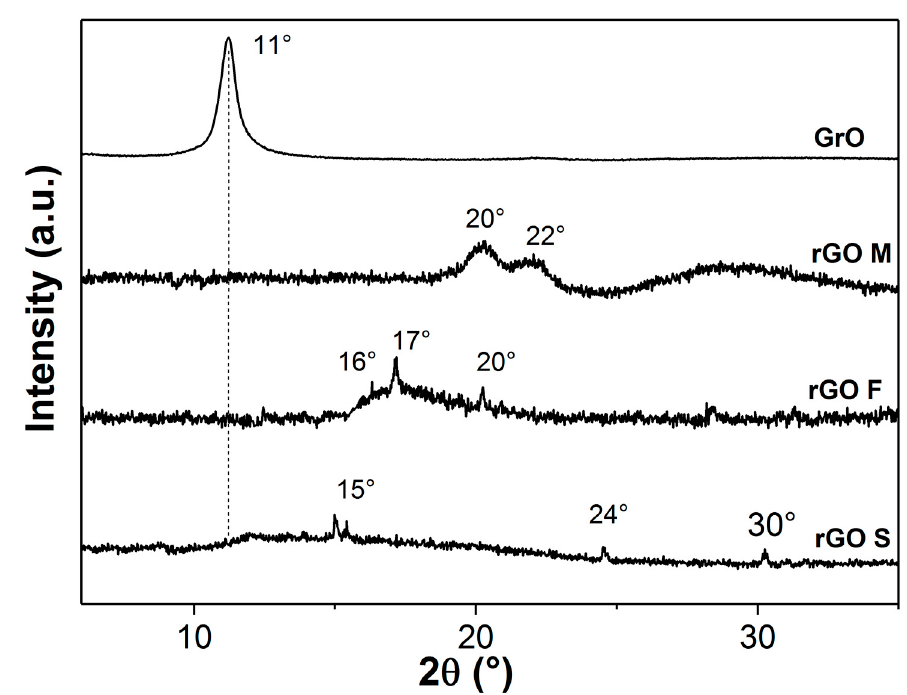
Figure 5. X-ray diffraction patterns of graphite (GrO), rGO S, rGO F, and rGO M nanohybrids.